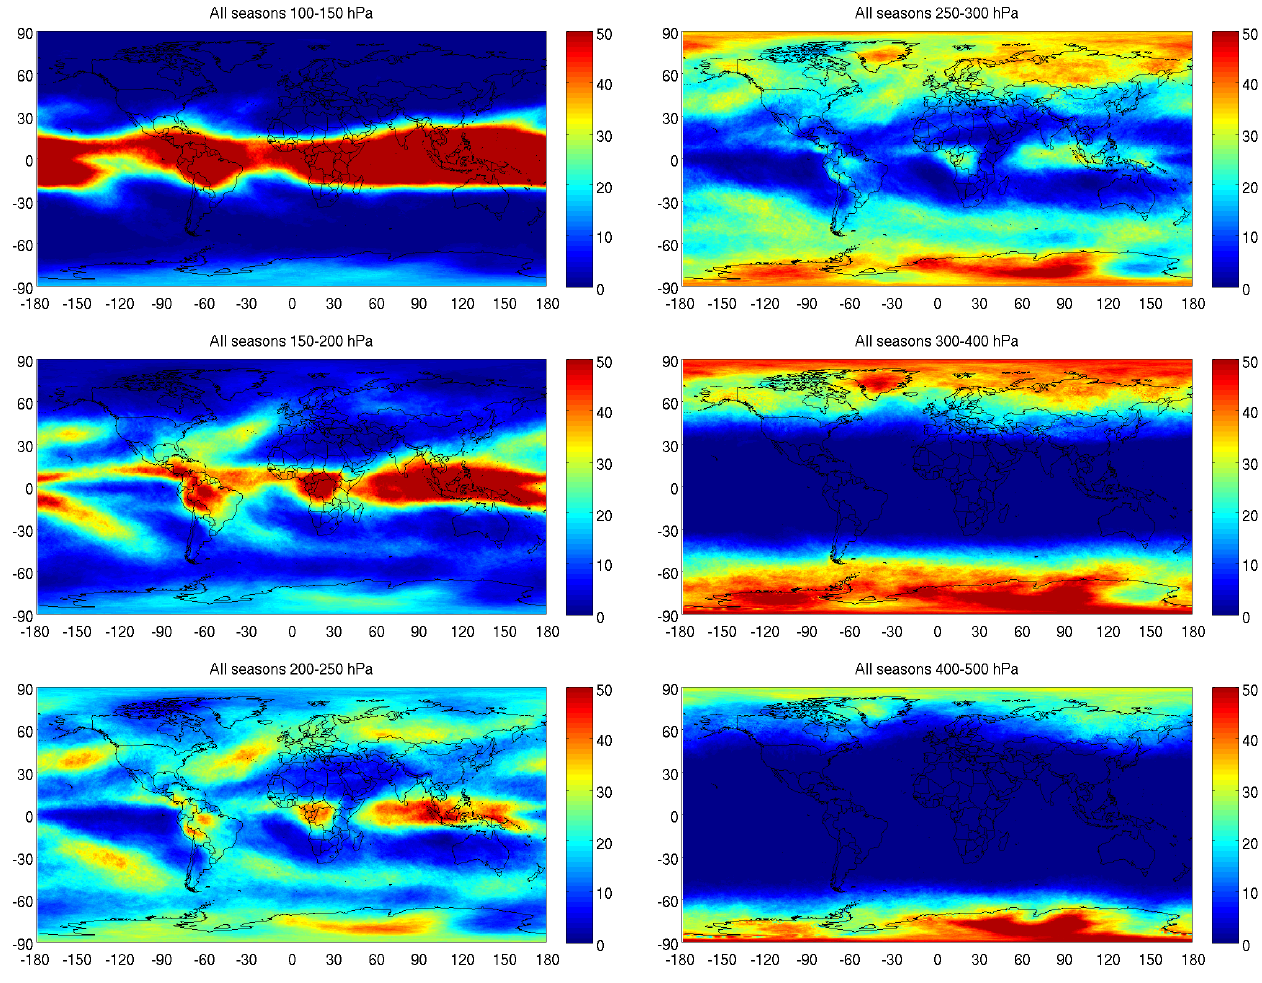
Fig. 15. Ice supersaturation occurrence frequencies (%) from ECMWF (“layer supersaturation” scheme) in the pressure layers